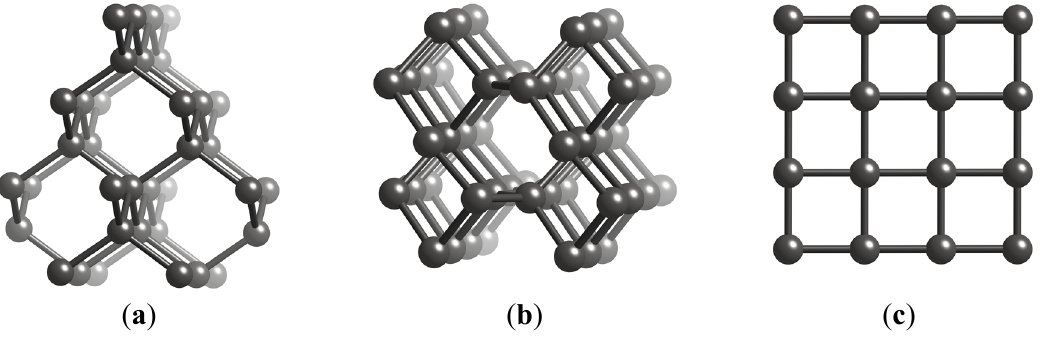
Figure 1. Network topologies with four-connected branching points or vertices: ( a ) The dia -net based on the diamond structure; ( b ) The chiral qtz -net based on the quartz structure; ( c ) The 2D sql